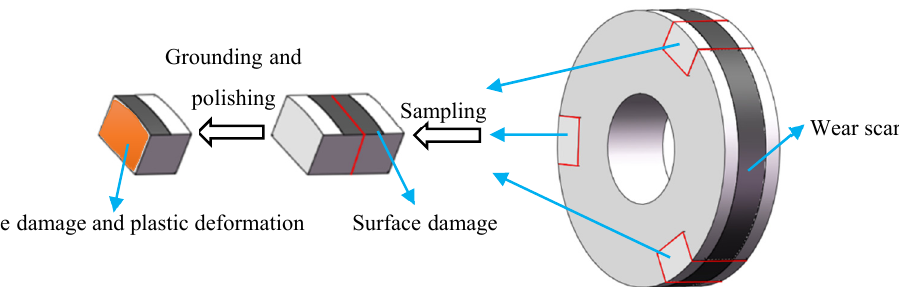
Figure 4. Sampling positions of surface and cross sections of the wheel/rail rollers for examination after wear testing.